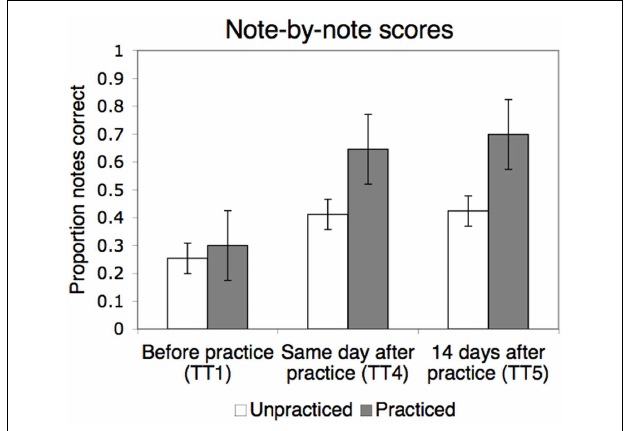
FIGURE 3 | Mean proportion of correctly played notes in LSJ’s sight-reading performances on the viola before practice, after practice on the same day, and after a 14-day delay (TestTrials 1, 4, and 5, respectively) . Results have been collapsed across the two practiced pieces, Piece A and Piece B. Error bars represent standard error of the mean.